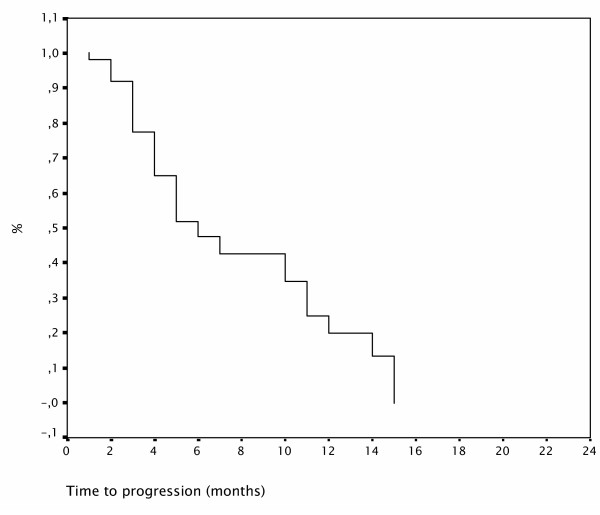
Progression free survival curve